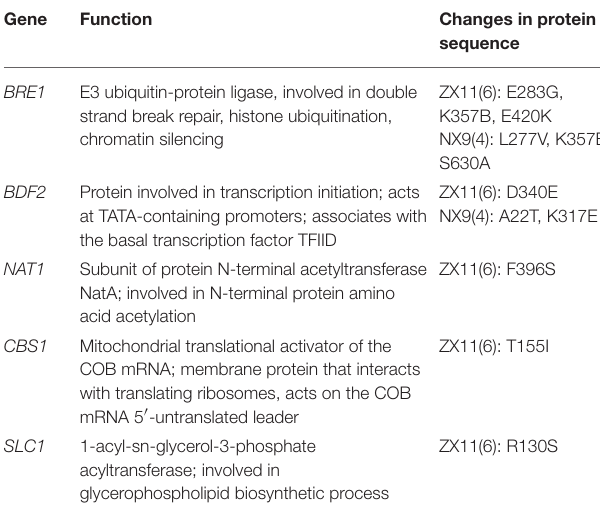
Mitochondrial translational activator of the COB mRNA; membrane protein that interacts with translating ribosomes, acts on the COB mRNA 5 ′ -untranslated